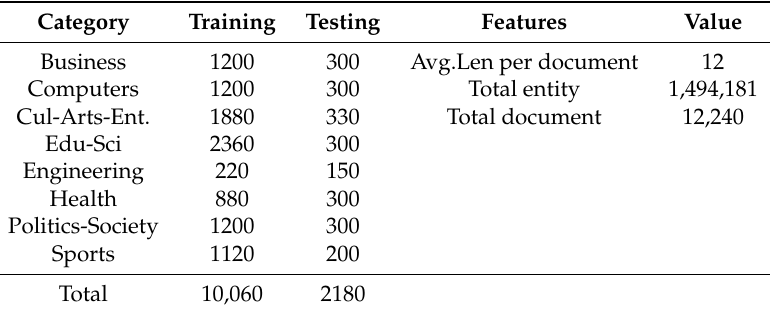
Table 1. The Google Snippet data set.